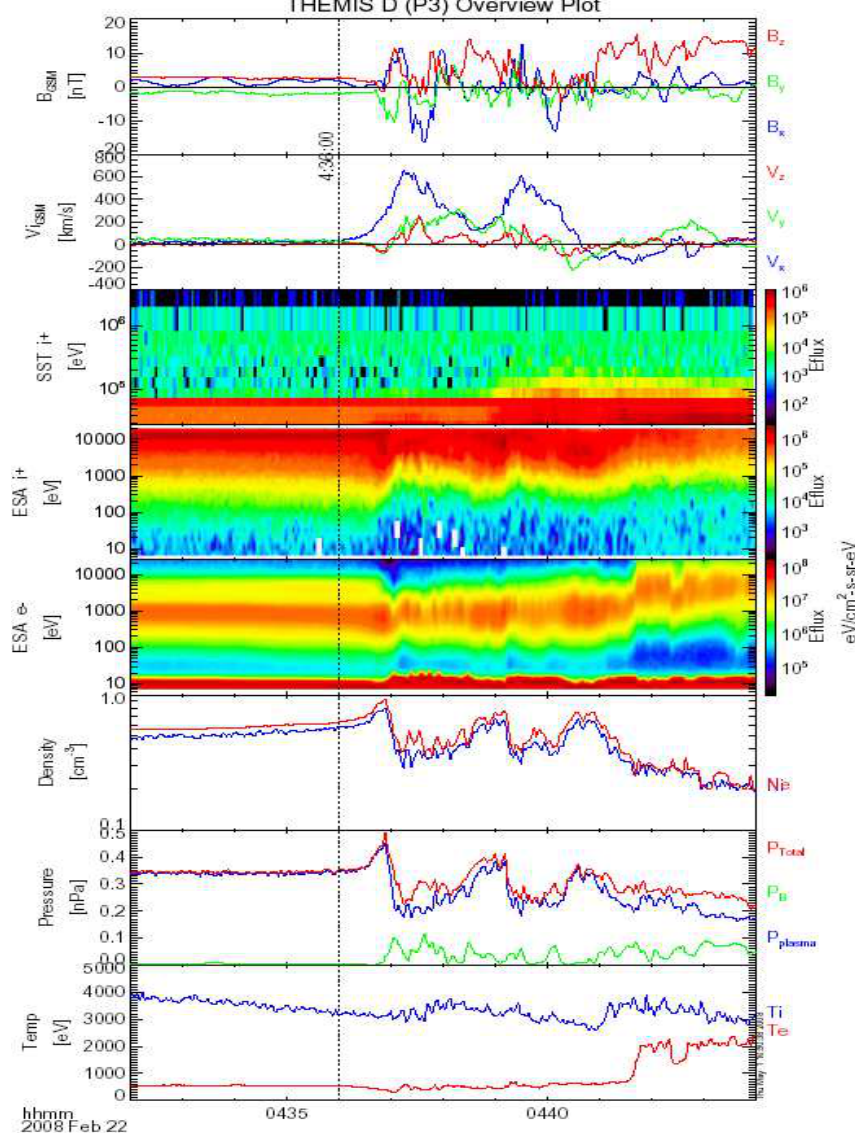
Fig. 6. Observations of THD on 22 February 2008 around